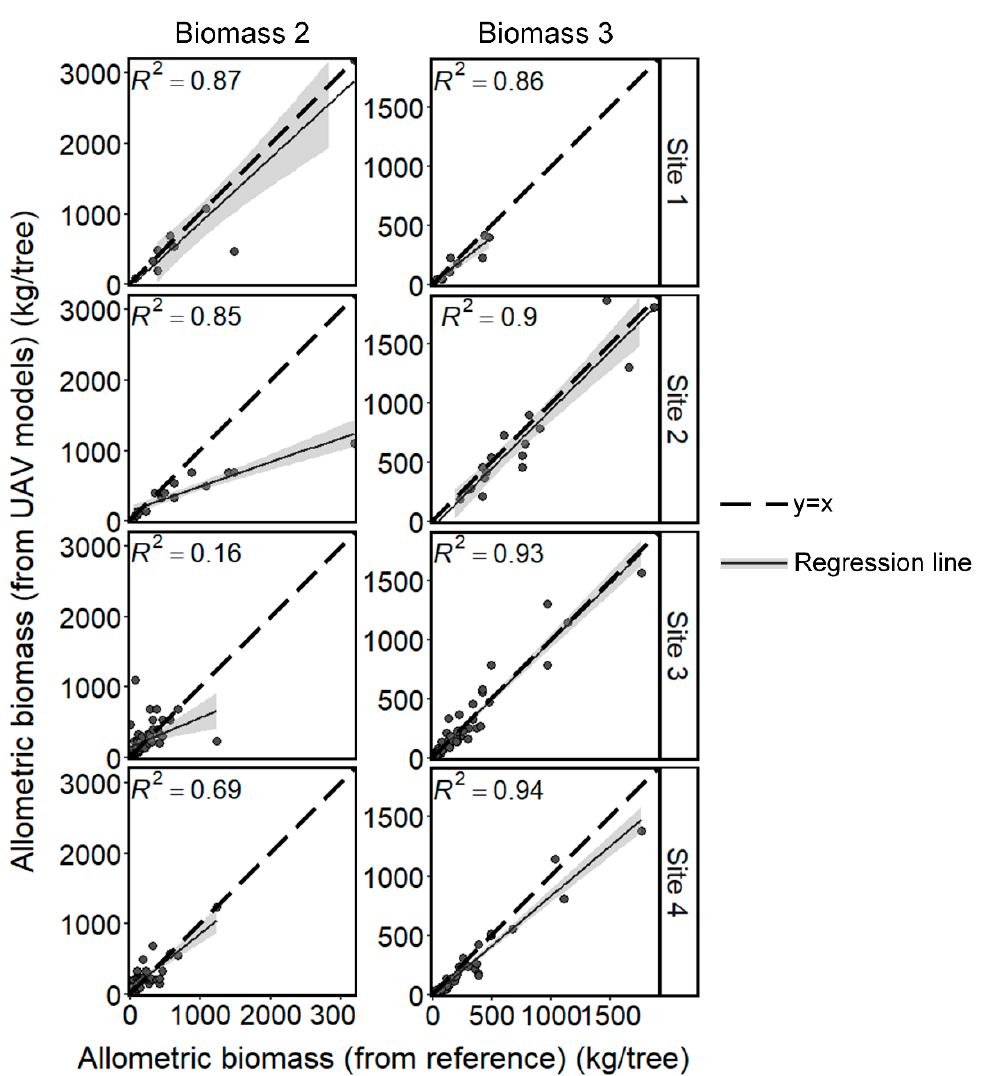
Figure A5. Site-specific AGB values obtained from allometric equations on variables measured by UAV (vertical axis) and reference values (horizontal axis) in high stands in Zone 2.